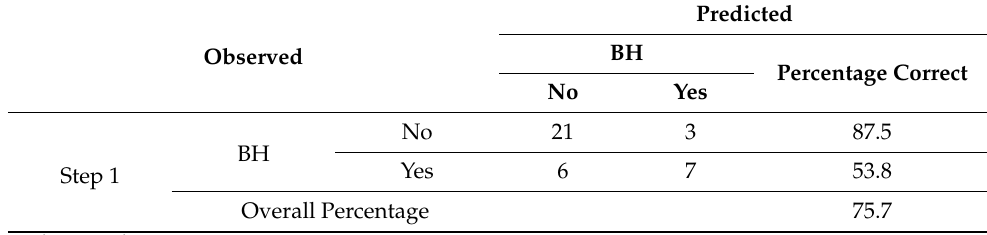
Table A1. Model classification table a .